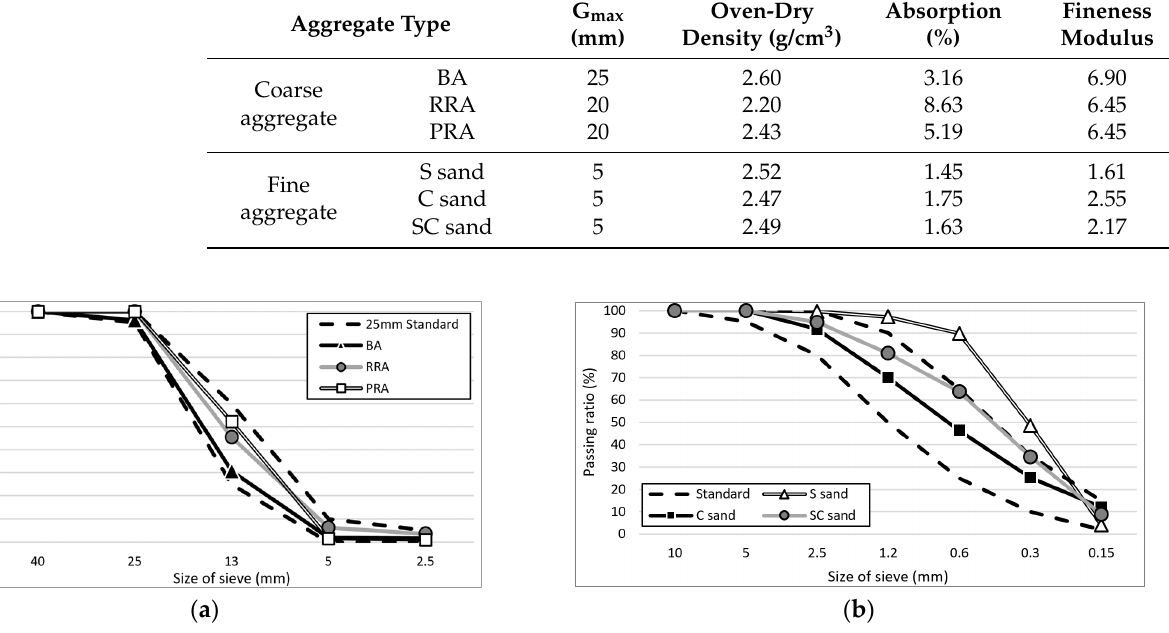
Figure 4. Grading of the aggregate used. ( a ) Coarse aggregate; ( b ) Fine aggregate. Table 6. Chemical composition of the aggregates.